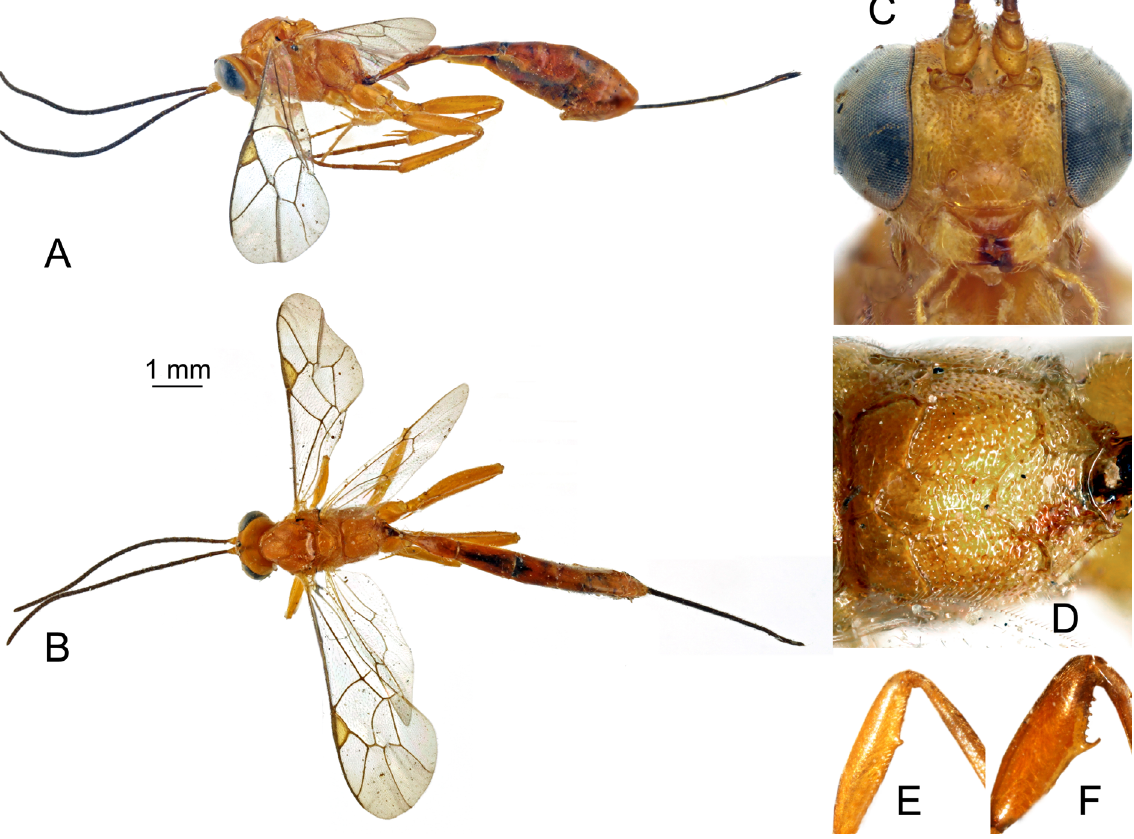
Fig. 12. Pristomerus patator sp. nov. A . ♀, habitus, profile. B . ♀, habitus, dorsal. C . ♀, head, facial. D . ♀, propodeum, dorsal. E . ♀, hind femur, profile. F . ♂, hind femur,